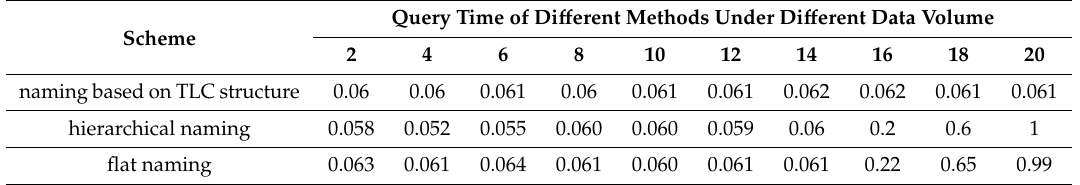
Table 6. Query time of di ff erent methods under di ff erent amount.